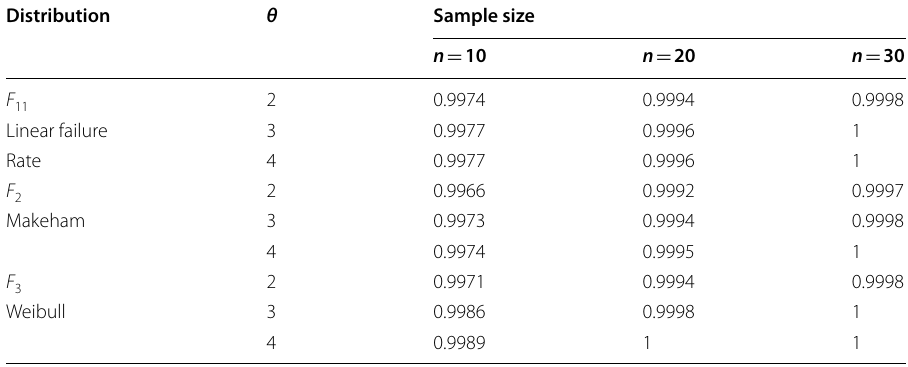
Table 3 Power estimate of ˆ (cid:31) U